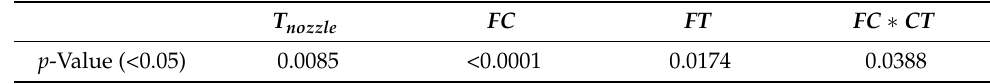
Table 6. p -values of various test parameters for strain.